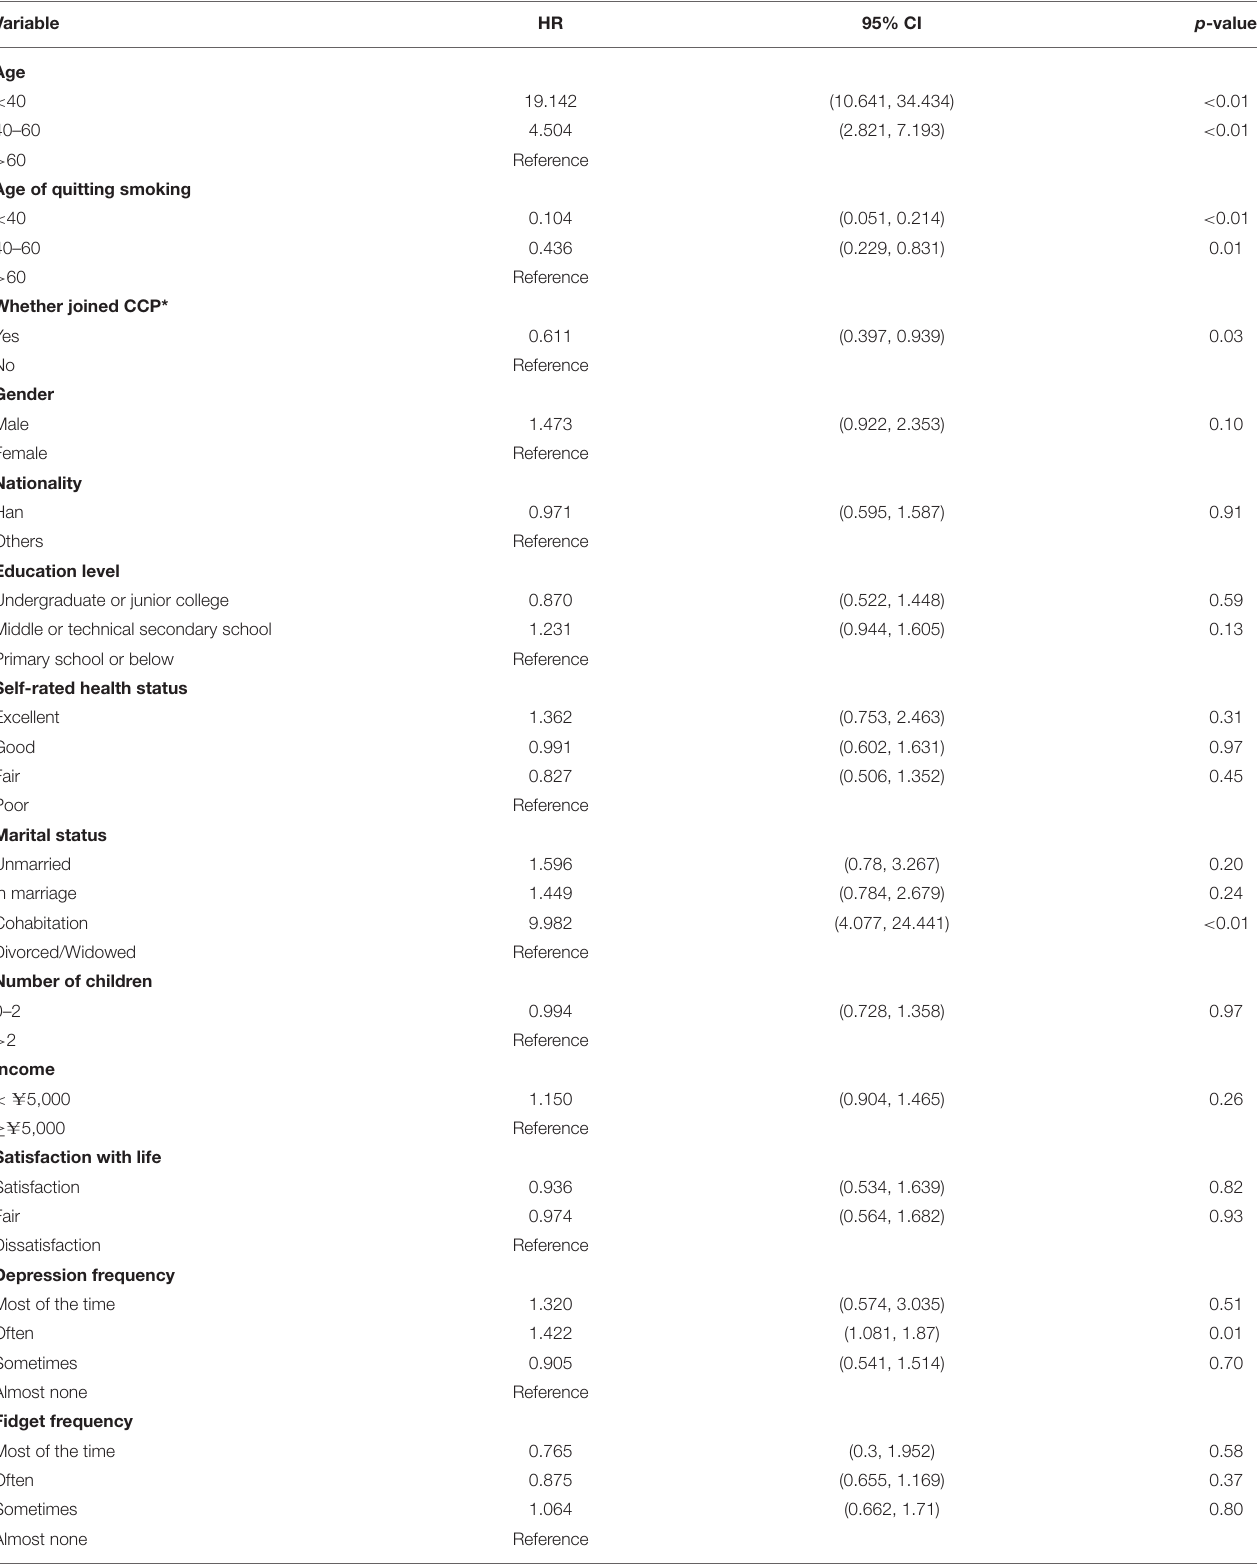
TABLE 2 | Multivariable competing risk analysis for